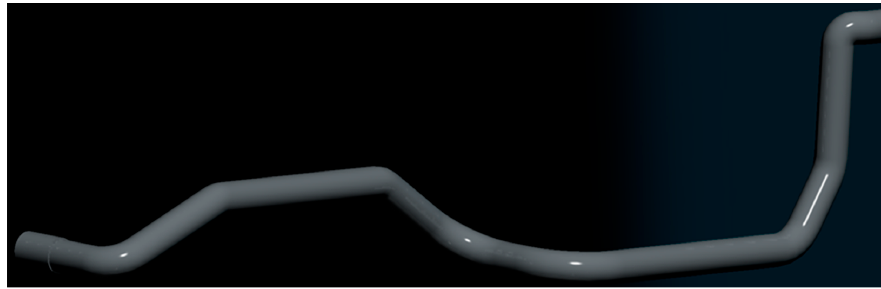
Figure 4. Geometric model of diesel engine exhaust pipe.